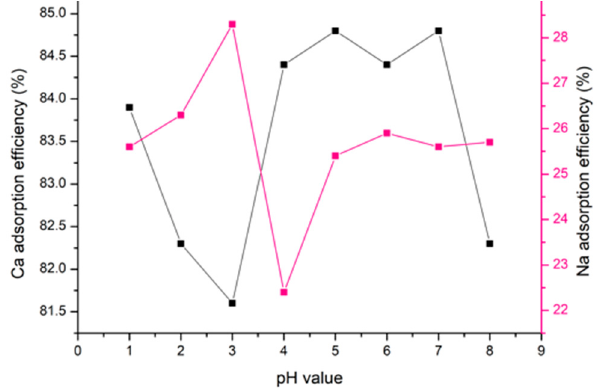
Figure 7. Adsorption efficiency on Ca 2+ and Na + with pH value.